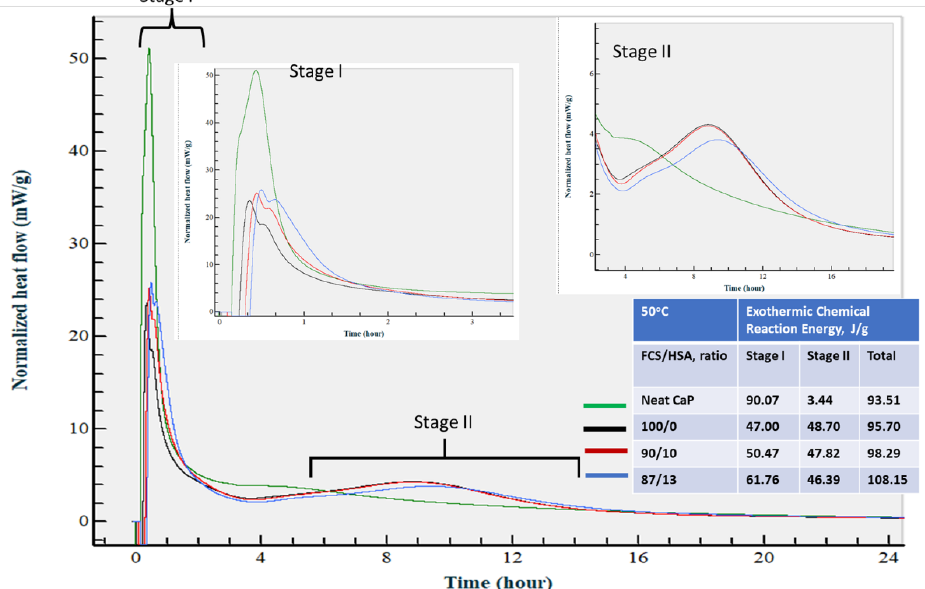
Figure 26. Calorimetric curves and normalized heat values for neat CaP cement and CaP composites made with FCS/HSA ratios of 100/0, 90/0, and 87/13 at temperature of 50 °C.